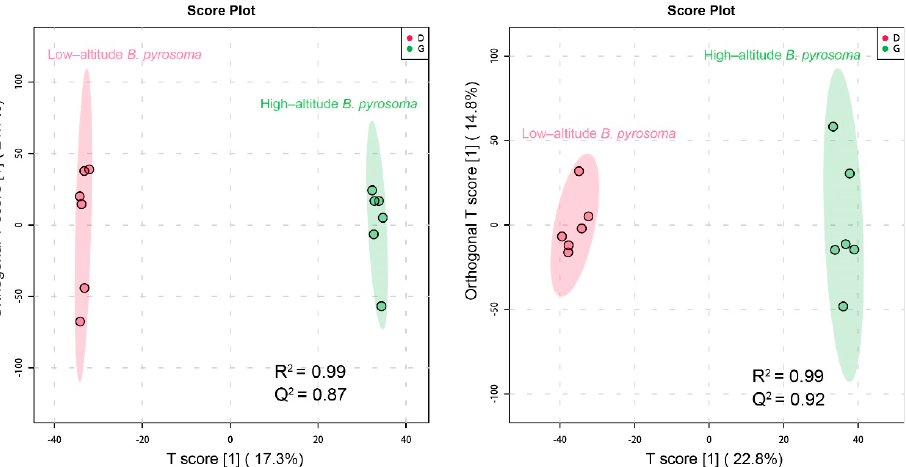
Figure 6. The score plots of orthogonal Partial Least Squares discriminant analysis (OPLS-DA) in negative and positive ion modes of the high-altitude and low-altitude B. pyrosoma , respectively, with n = 6 per group. D: low-altitude B. pyrosoma , G: high-altitude B. pyrosoma . In total, 484 differential metabolites were identified (Supplementary Table S2). Compared to the